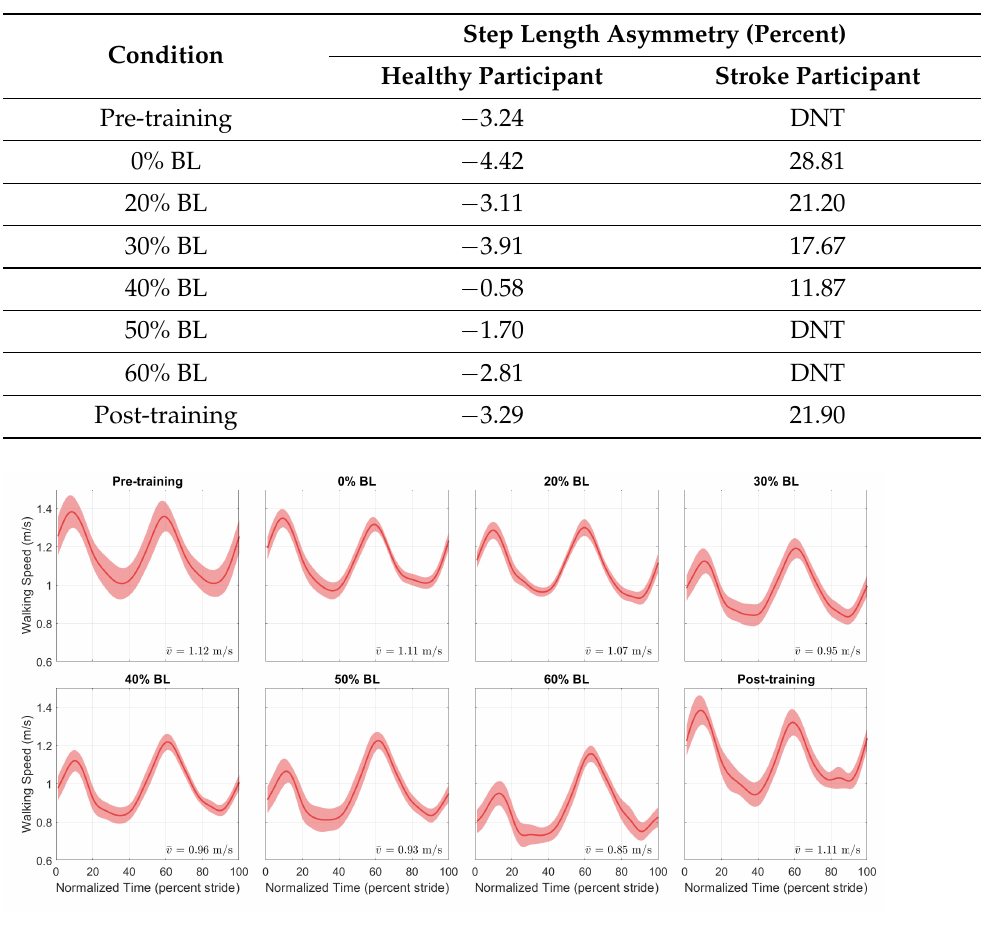
Figure 14. Speed profiles of the healthy participant. Each stride starts at resisted side heel strike (HS) and ends at the next resisted side HS.